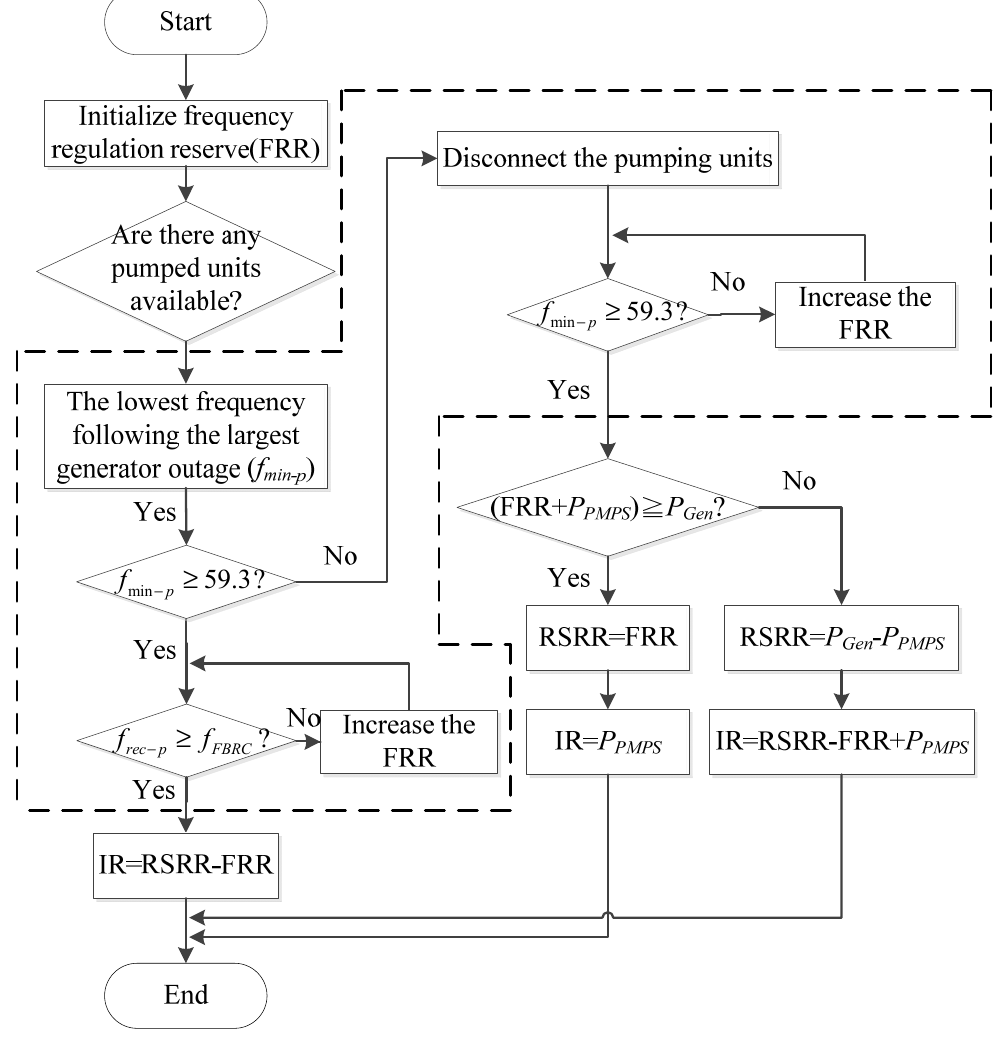
Figure 2. The flow chart of the dotted box for calculation of FRR including considerations of pumped storage